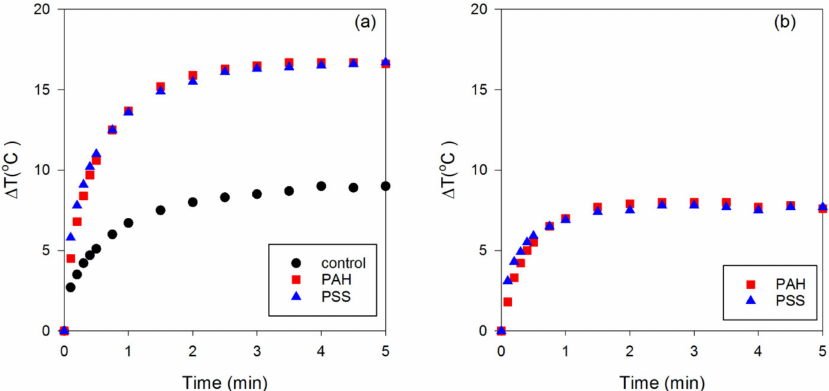
Figure 3. Increase in temperature of Milli-Q water (control), PSS-GNRs, and PAH-GNRs (30 µ L) after exposure to a 100 mW laser (at a wavelength of 635 nm). The changes in temperature were collected after 0 to 5 min of laser exposure of the sample solution. ( a ) Total temperature increase in the system and ( b ) temperature increase after subtracting baseline due to the well plate and presence of the